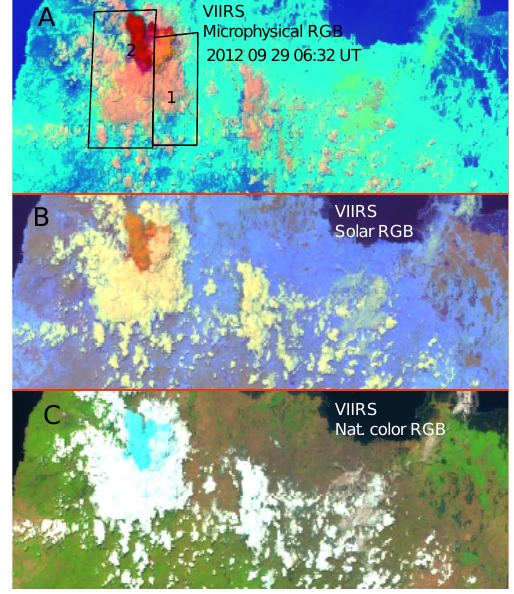
Fig. 20. Deep convection in smoky air over west Java, as seen by the VIIRS overpass on 29 September 2012, 06:32UT, in an area of 178km × 78km centered at 6.29 ◦ S, 106.55 ◦ E. The clouds de- veloped in diluted smoke that was transported from forest fires in Sumatra. Note that area 1 includes a growing cloud with top tem- peratures reaching − 32 ◦ C and yet is not glaciated. Area 2 includes an older cloud top that is glaciating between − 10 and − 20 ◦ C (see Fig. 22e).